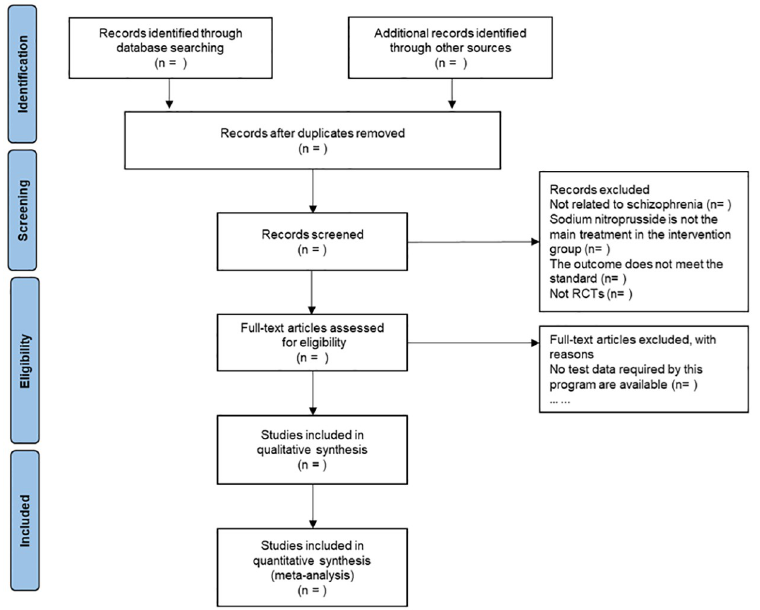
Fig 1. PRISMA flow diagram showing the study selection